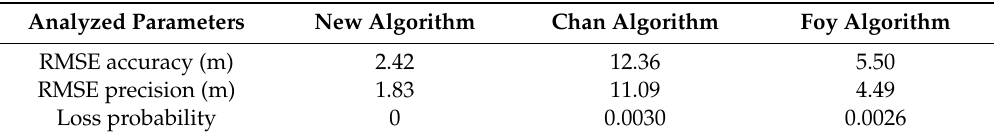
Table 2. Results of comparative analysis when all devices were deployed within one corridor, with assurance of good geometry.